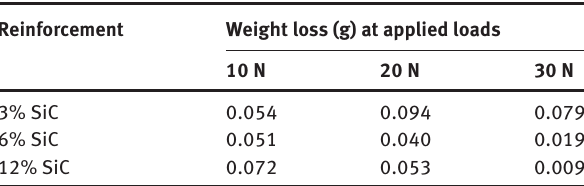
Table 4: Abrasive wear amounts of the composite sprecimens after the tests Reinforcement